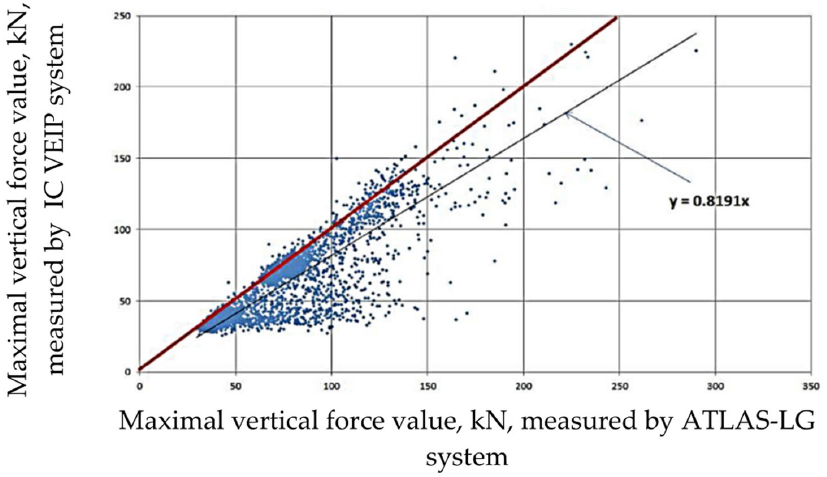
Figure 9. Correlation of measured values of maximal vertical forces according to measurement systems.